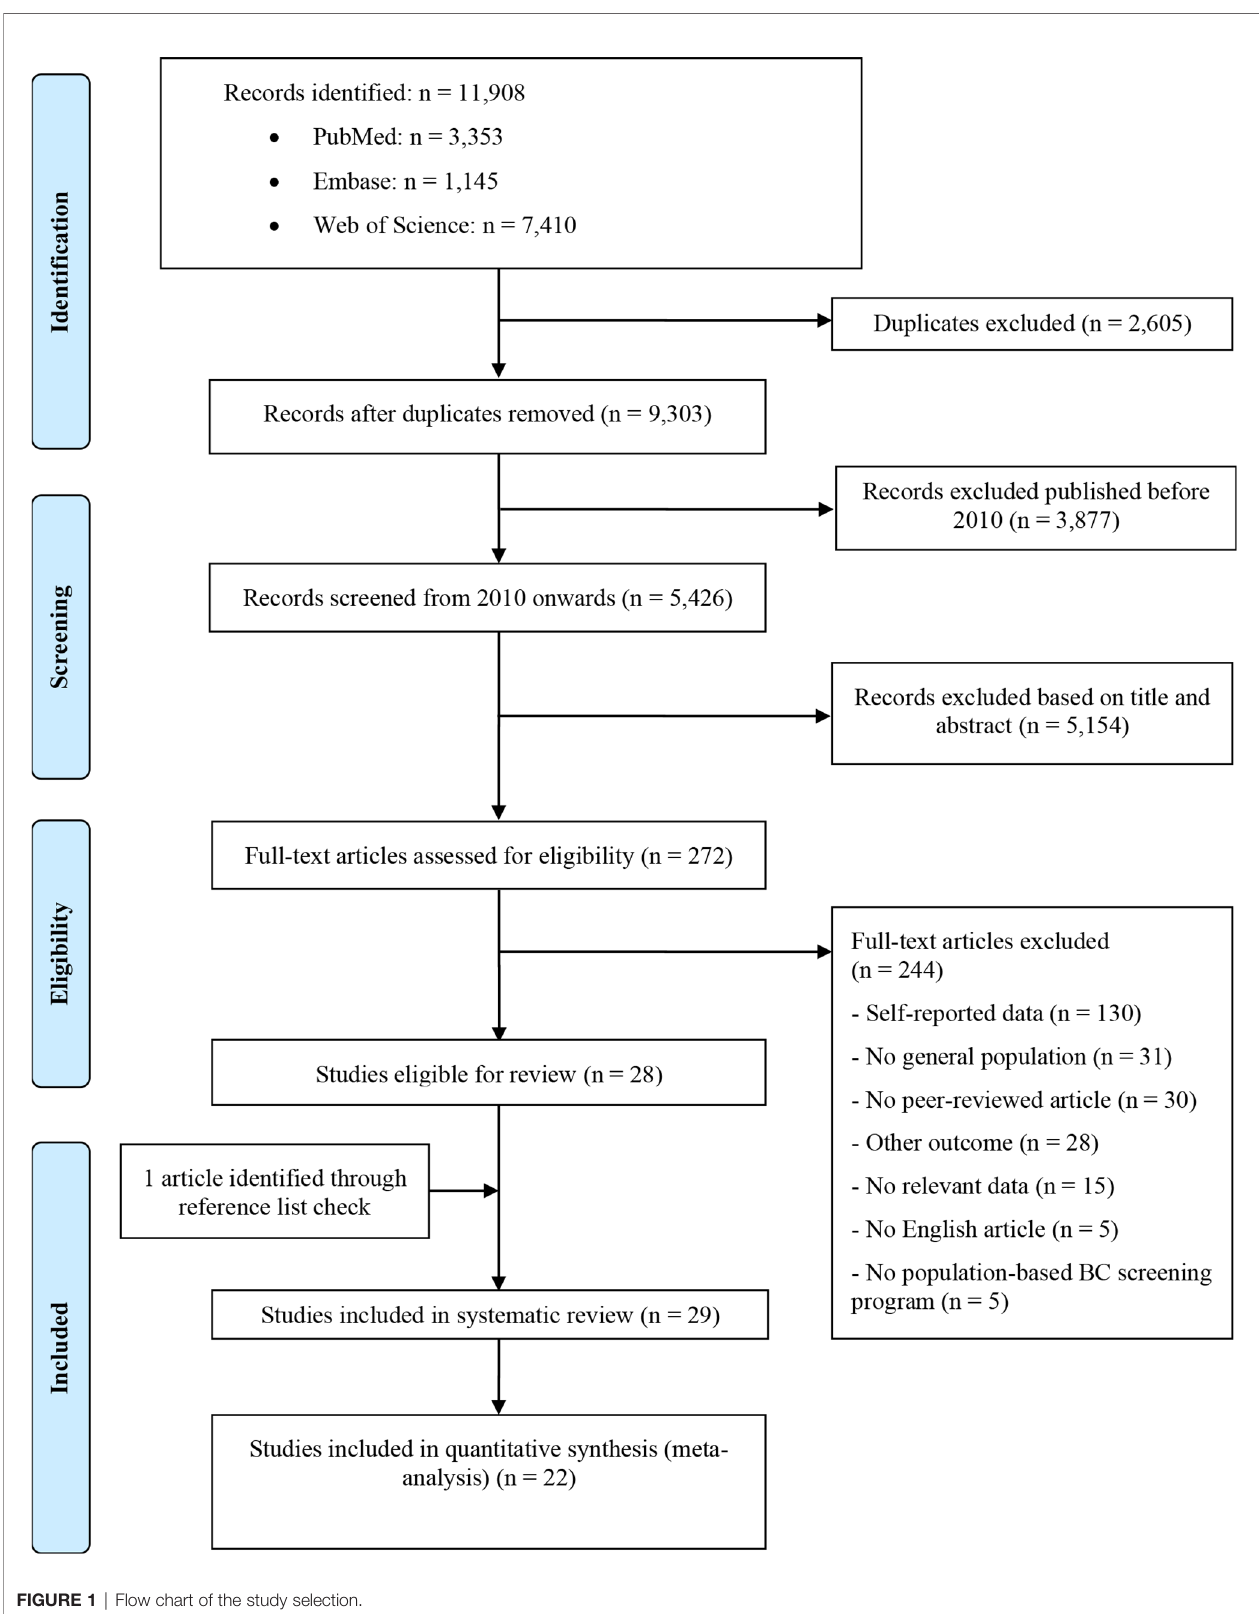
FIGURE 1 | Flow chart of the study